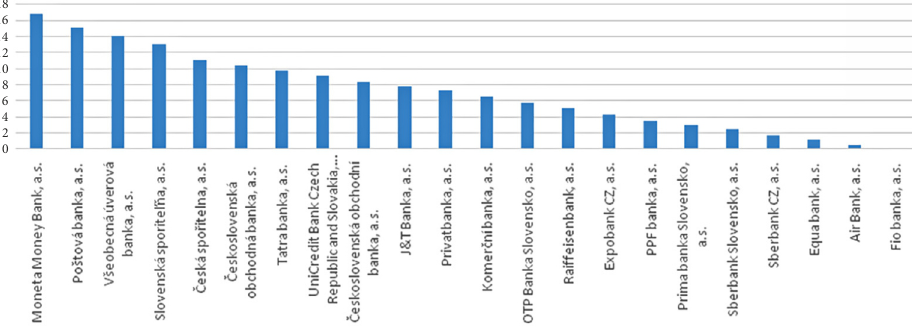
Table 5. Final ranking based on individual methods Bank